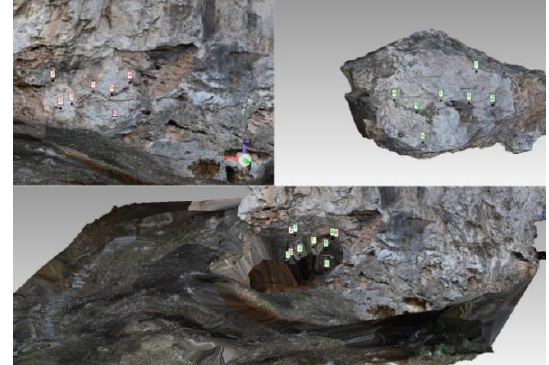
Figure 5: Alignment of the model of the hill-cliff and the rock 1A.